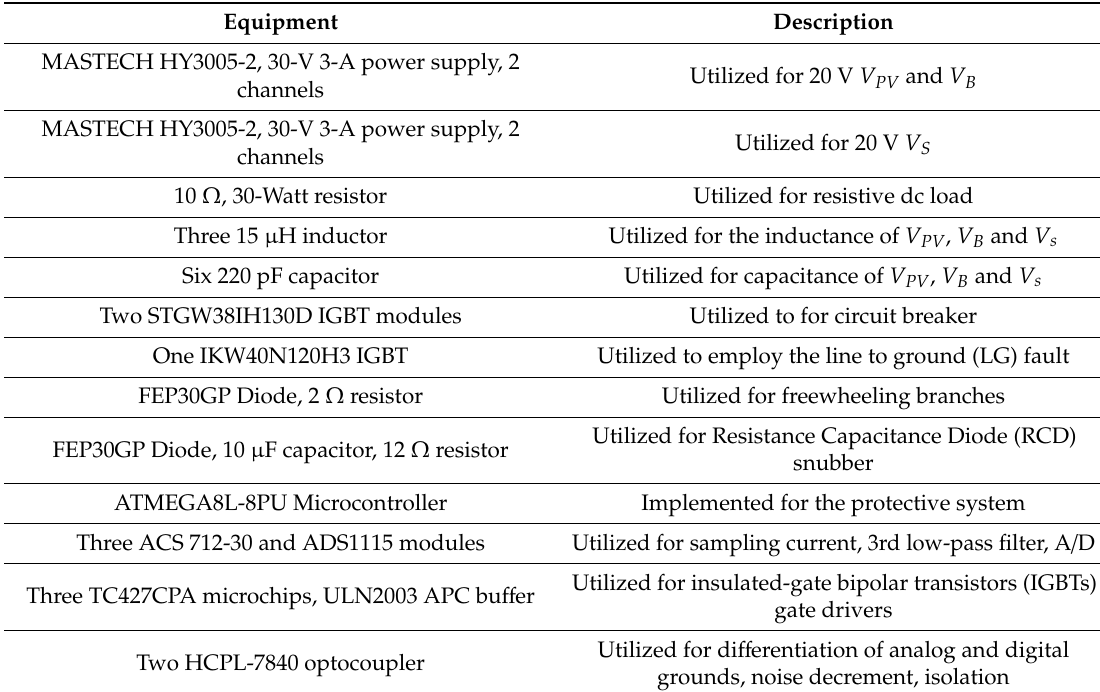
Table 2. Equipment Description.